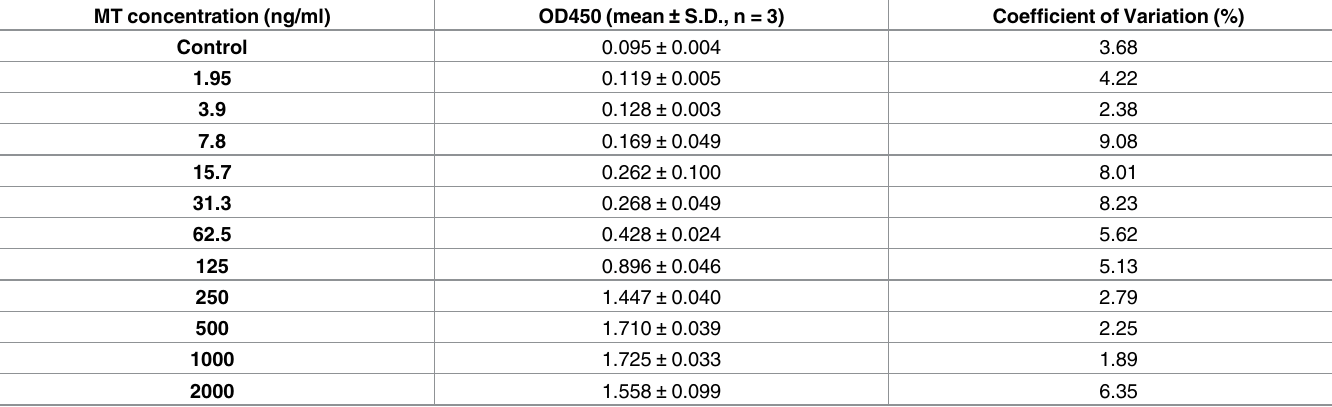
Table 6. The OD 450 and its coefficient of variation of a serial of MT concentration. MT concentration